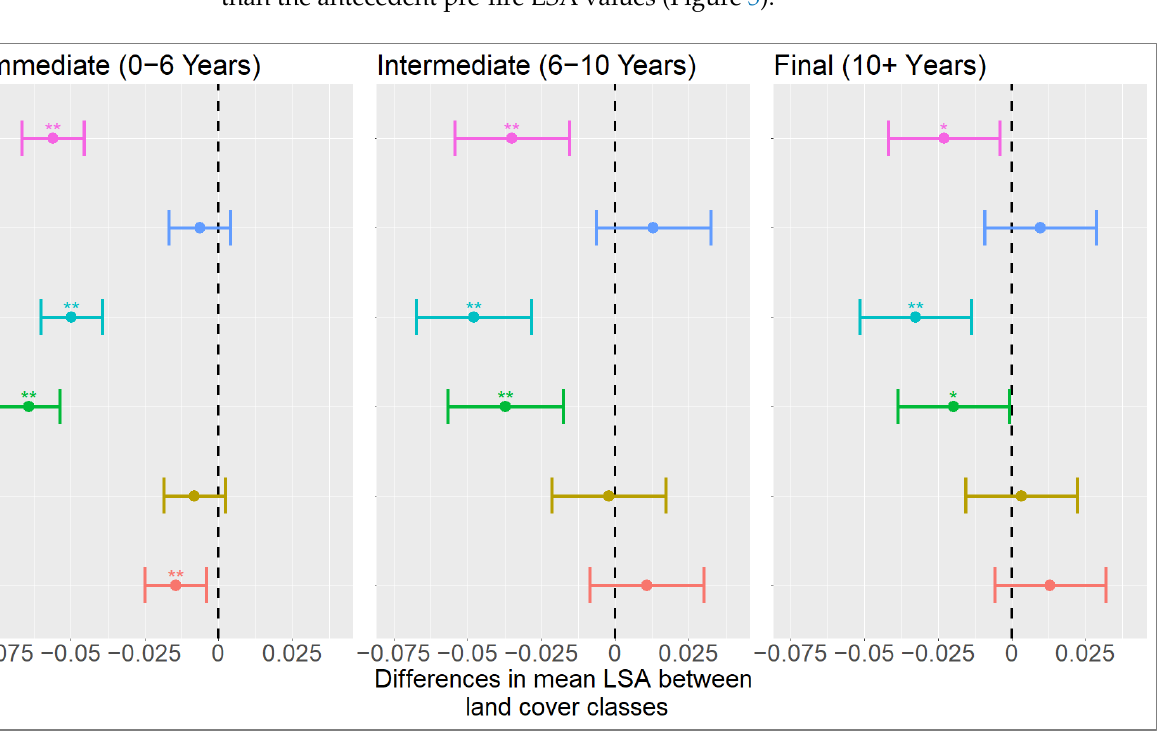
Figure 5. Tukey plot of post-fire LSA decay over post-fire recovery stages (0 – 6 years, 6 – 10 years, 11+ years-since-fire) shows significance in pairwise differences between burn severity classifications in the burned regions. A vertical dashed line in each plot indicates the area in which differences overlapping it are not significant, and those differences not overlapping the line are significant ( p -value <